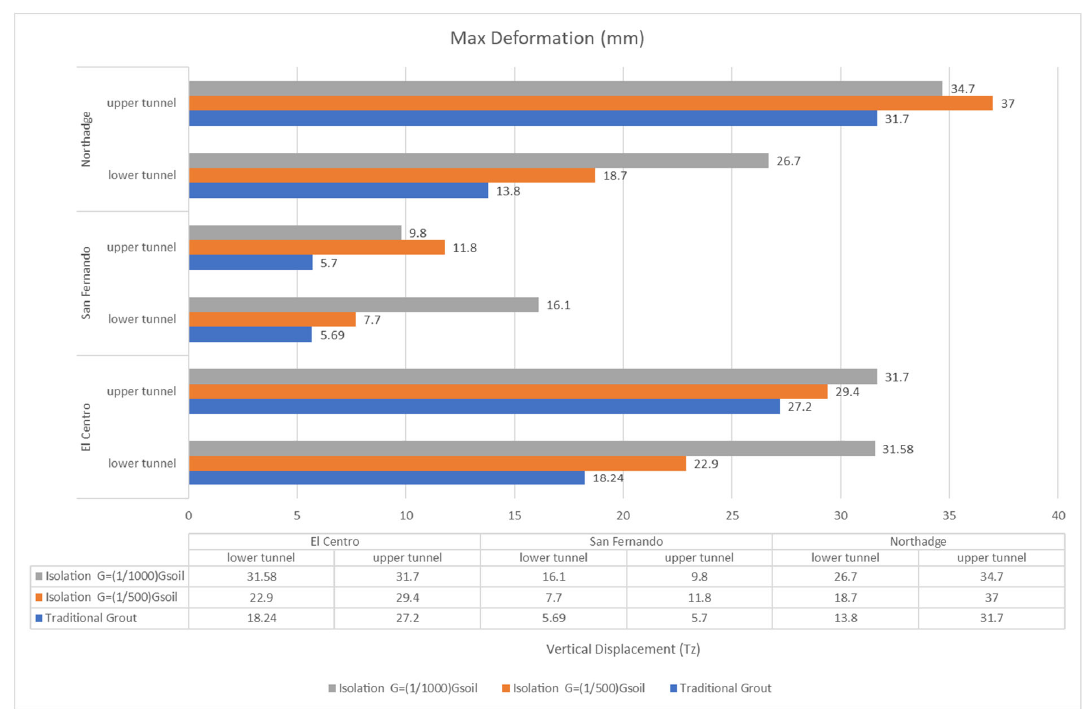
Figure 16. Maximum vertical displacement of twin tunnels in soft soil.